Question: Name the type of graph shown.
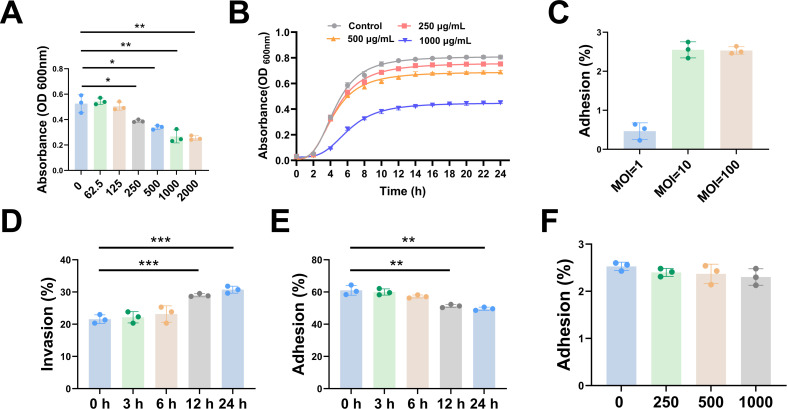
Answer: bar